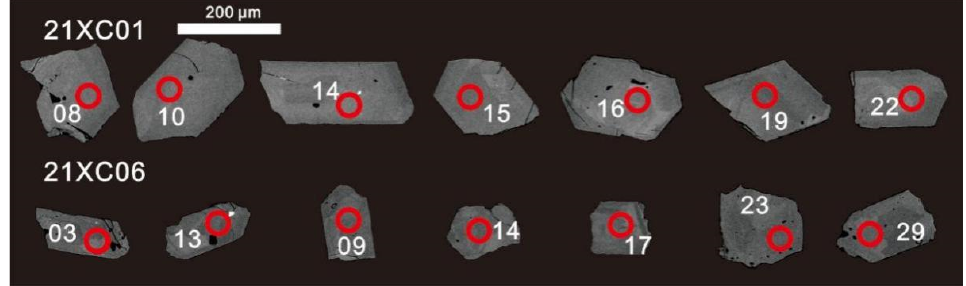
Figure 6. BSE image of sphene grains from syenogranite and quartz monzonite. The red circles indicate spots of LA-ICP-MS U-Pb dating.